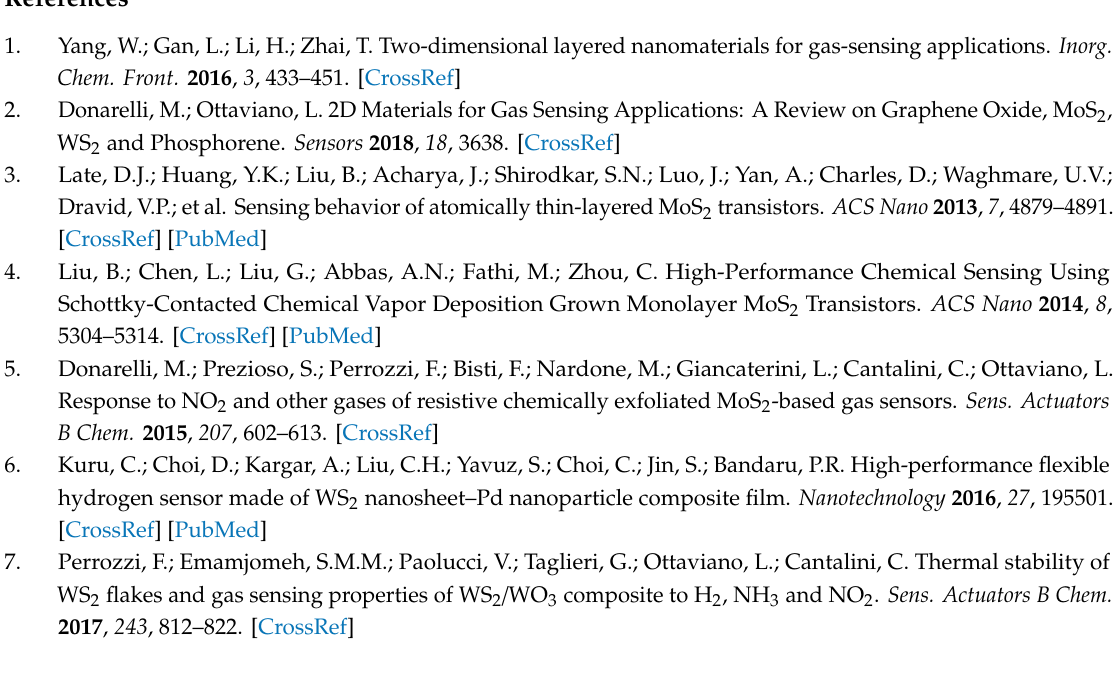
Figure S1: Schematic illustration of WS2 exfoliation process, Figure S2: Grazing incidence XRD spectrum of WS 2 -decorated rGO film, Figure S3 : Reproducibility and base line recovery features of the WS 2 -decorated rGO by exposing the film to both dynamic and cumulative NO 2 concentrations (5–10 ppm) under light irradiation (purple blue), Figure S4. Long term stability properties of the WS 2 / rGO hybrid sensor, Selectivity response of the the WS 2 / rGO hybrid sensor to di ff erent oxidizing and reducing gases, measured at 50 ◦ C operating temperature under purple-blue